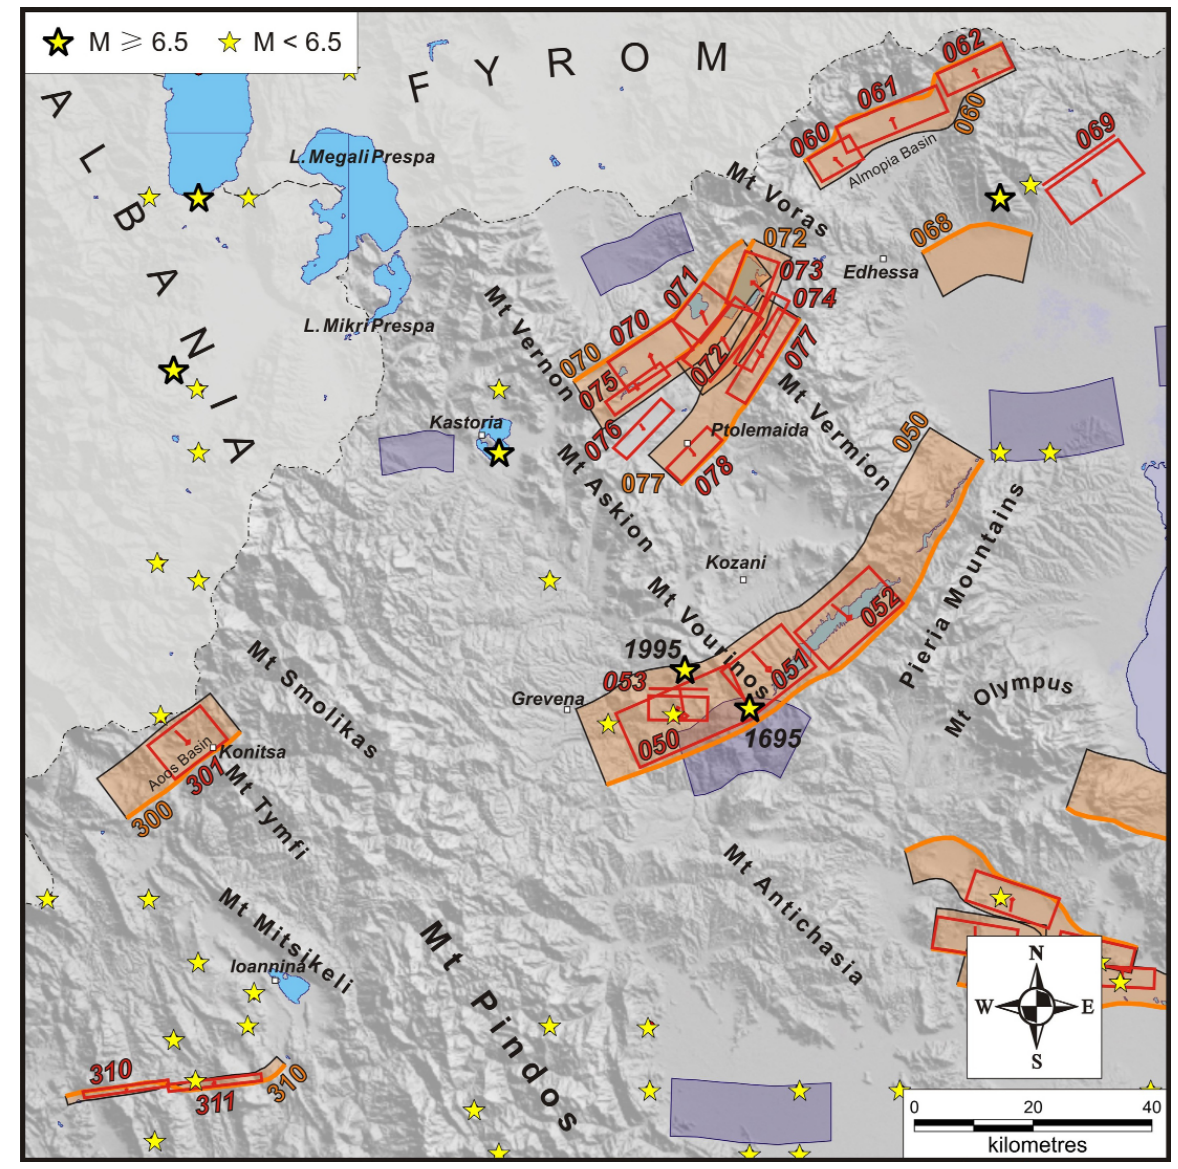
Figure 5. Map detail of the seismogenic sources belonging to the "anti-Hellenides fault system". See Figure 1 for map location and seismogenic sources. Three-digit labels refer to the database code of the seismogenic source (ISS codes in italics). Years are provided for major earthquakes discussed in the main text (see also Table